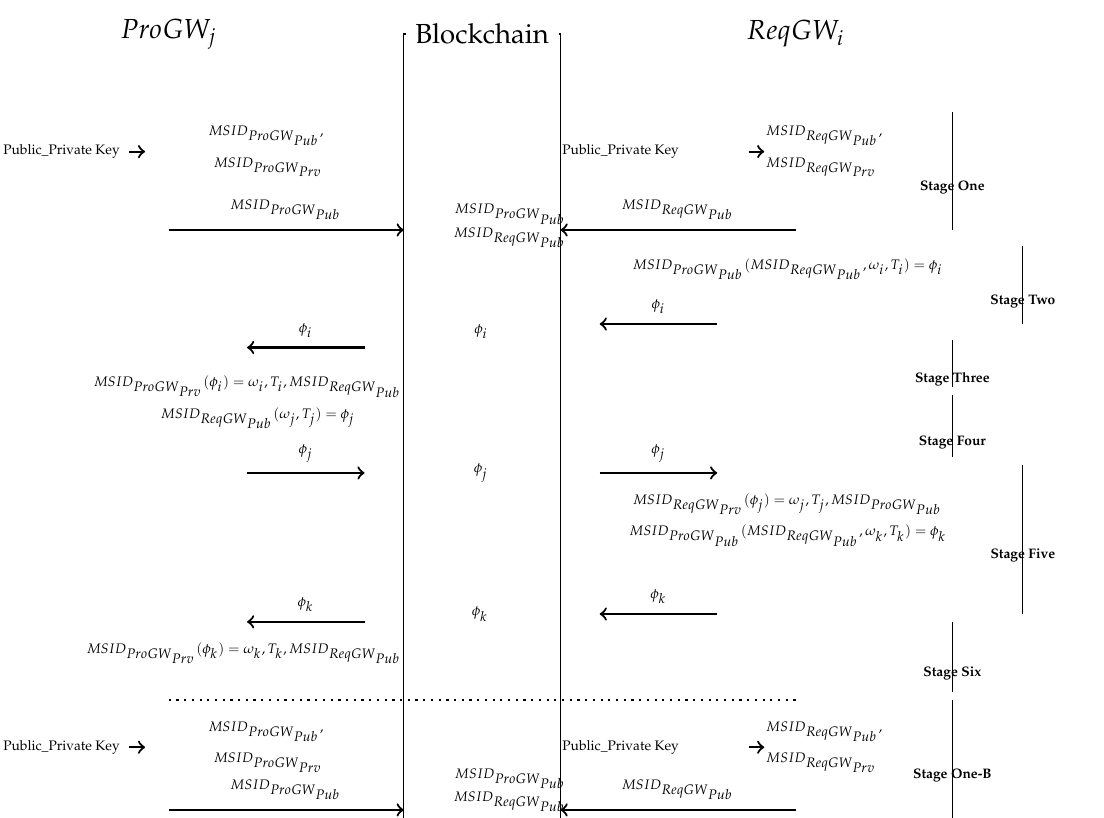
Figure 2. Proposed Anonymity and transactional data Privacy protection protocol operation flow